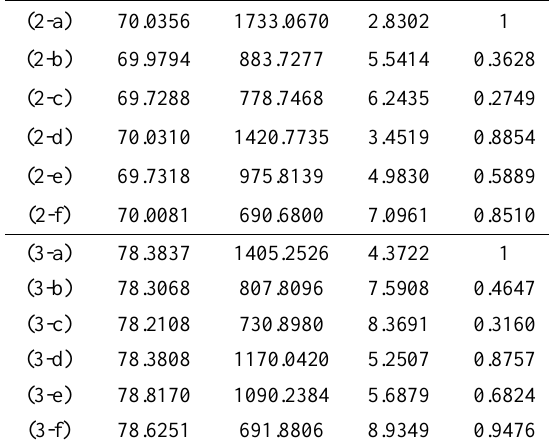
Table 1. Comparison of performance for SAR images